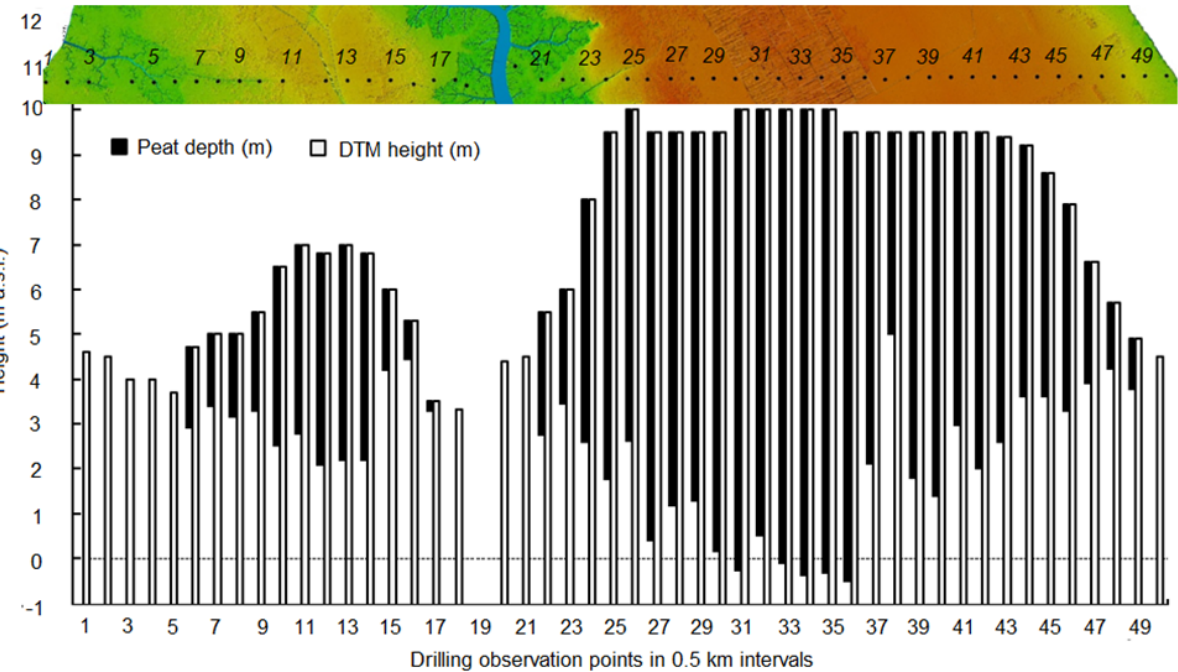
Figure 5. Longitudinal section from north (left-hand side of diagram) to south along Transect CS1. Above the profile, the plan locations and numbering of survey points are superposed on a strip of the DTM shown in Figure